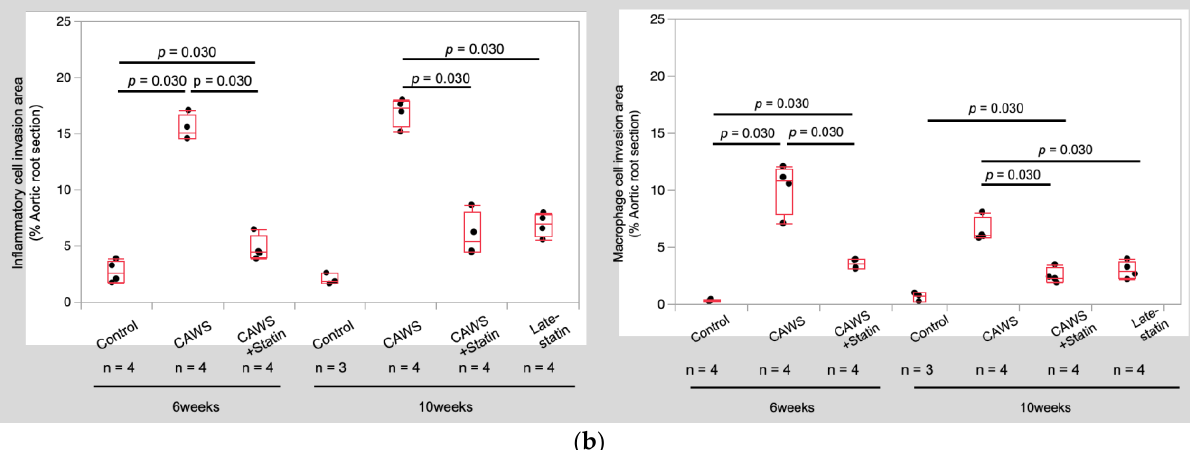
Figure 3. Histological findings at the aortic root. ( a ) Histological findings at the aortic root after 10 weeks of CAWS administration. Histological evaluation of inflammatory or macrophage cell invasion into the sinus area of the aortic root of Apo E-/- mice. Statin treatment suppressed the infiltration of inflammatory cells and macrophage cells at the aortic root; the anti-inflammatory effect of statins was also observed in the late-statin group. ( b ) Inflammatory cell invasion area and macrophage cell invasion area ratios. Inflammatory cell and macrophage cell invasion area ratios were calculated and compared between groups. Area ratios were expressed as percentages. CAWS promoted inflammatory and macrophage cell infiltration at both 6 and 10 weeks after CAWS administration. Statins also significantly inhibited the infiltration of inflammatory cells and macrophage cells at both 6 and 10 weeks after CAWS administration. In the late statin group, statins suppressed the inflammatory cell invasion area ratio. Means and SD are shown.Upper, H&E staining; lower, anti-MAC-2 antibody staining. (Bar = 500 μm).